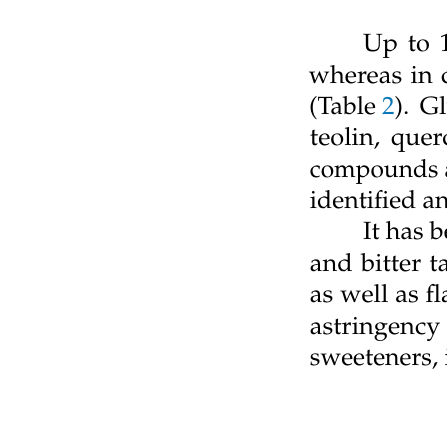
astringency taste in red wines [1,22]. This intense flavor is counterbalanced by adding sweeteners, improving consumer preference